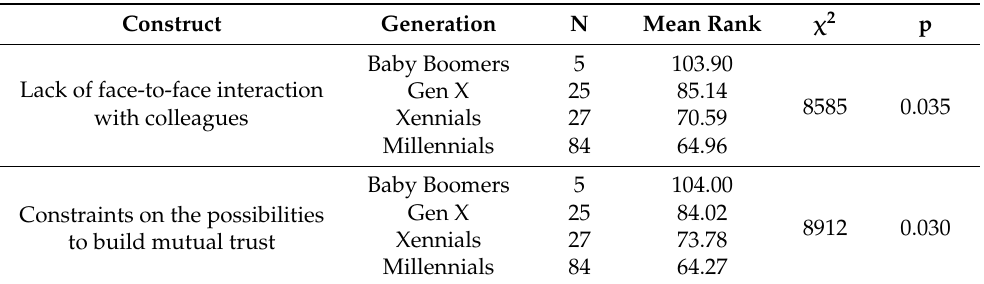
Table 3. The evaluation of teleworking among generations which were telecommuting for sev- eral